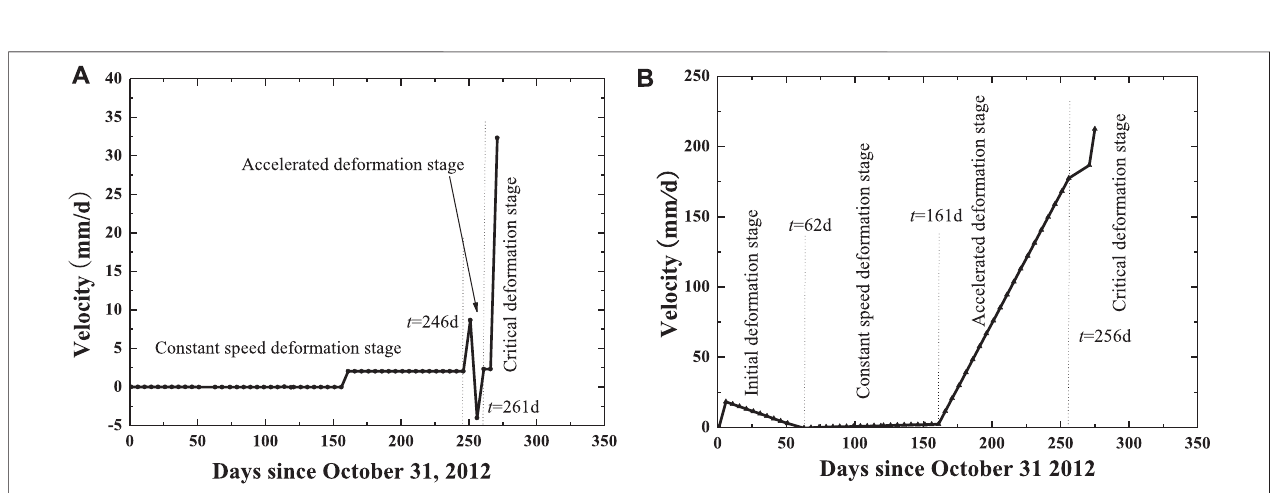
FIGURE 10 | Relationships between velocity and time at the depth of 17 m based on the deep displacement data obtained from (A) 1# SAA and (B) 2# SAA.